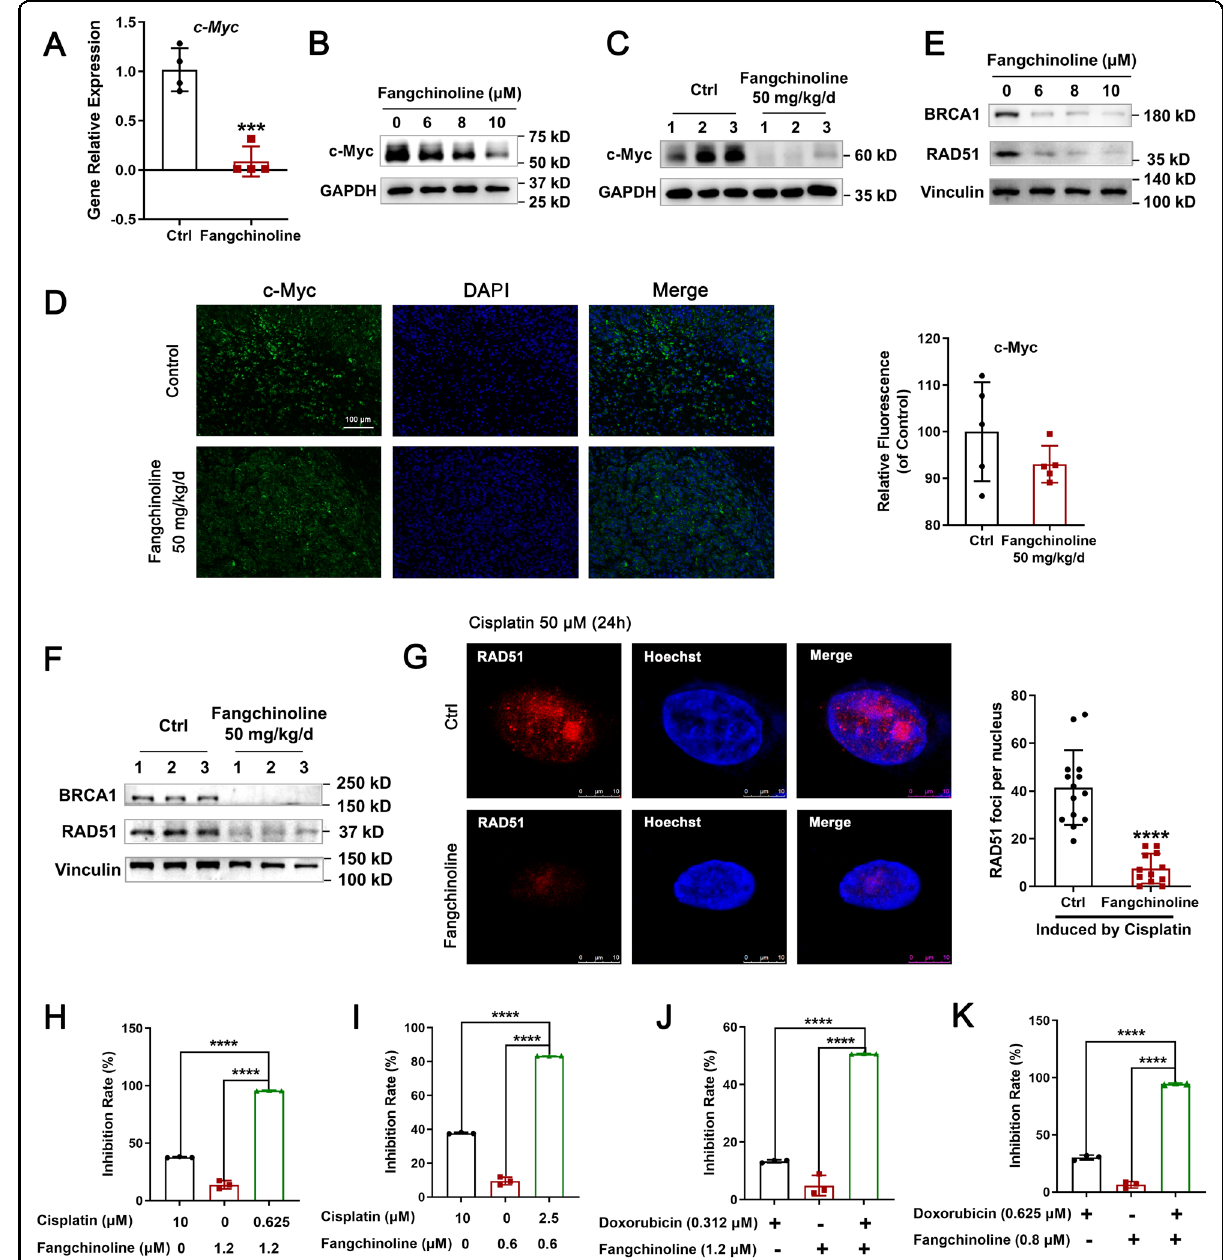
Fig. 4 Fangchinoline suppressed the HR pathway and increased sensitivity to DNA damage-inducing drugs. A Transcriptional expression of c-Myc was decreased in CM-AS16 cells after treatment with 8 μ M fangchinoline. n = 4. B The protein level of c-Myc was decreased in a dose- dependent manner in CM-AS16 cells after treatment with fangchinoline. n = 3. C An immunoblotting assay revealed that the protein level of c-Myc was decreased in CM-AS16 tumour tissues after treatment with 50 mg/kg fangchinoline daily. n = 3. D An immuno fl uorescent assay revealed that the protein level of c-Myc was decreased in CM-AS16 tumour tissues after treatment with 50 mg/kg fangchinoline daily. Data are shown as the mean ± SD, n = 5. Scale bar: 100 μ m. E The protein levels of the HR factors BRCA1 and RAD51 were decreased in a dose-dependent manner in CM-AS16 cells after treatment with fangchinoline. n = 3. F The protein levels of the HR factors BRCA1 and RAD51 were decreased in CM-AS16 tumour tissues after treatment with 50 mg/kg fangchinoline daily. n = 3. G Representative images of RAD51 foci induced by cisplatin (50 μ M for 24 h) in CM-AS16 cells after treatment with or without 1.2 μ M fangchinoline [red: RAD51; blue: Hoechst]. Scale bar: 10 μ m. Fangchinoline signi fi cantly decreased the number of RAD51 foci induced by cisplatin. n = 3. H , I Fangchinoline increased the sensitivity of CM-AS16 cells to cisplatin. J , K Fangchinoline increased the sensitivity of CM-AS16 cells to doxorubicin. n = 3. Data represent the mean ± SD of three independent experiments. * P < 0.05, *** P < 0.001, **** P < 0.0001, by Student ’ s t